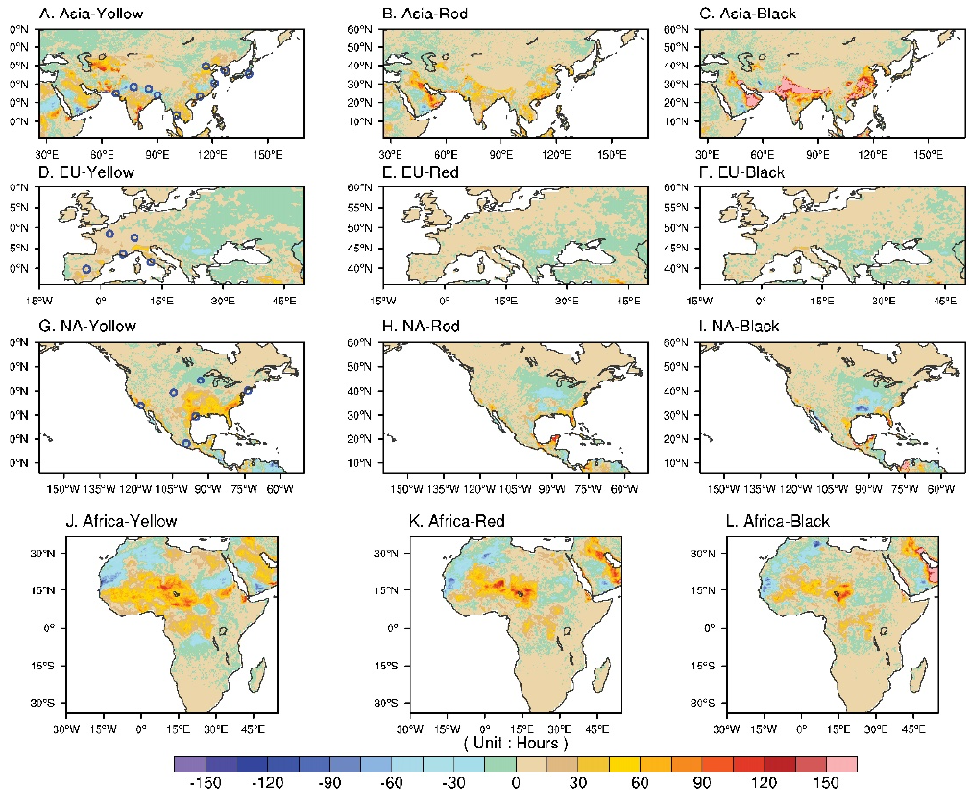
Figure 2. Difference in JJA rest hours between the periods of 2015–2019 and 2010–2014 (former minus the latter): ( A – C ) difference in rest hours due to yellow, red, and black flag conditions in continental Asia; ( D – F ) same as in ( A – C ) but for Europe; ( G – I ) same as in ( A – C ) but for North America; and ( J – L ) same as in ( A – C ) but for Africa. Blue dots on ( A , D , G ) show the geographic locations of selected urban cities in this study.